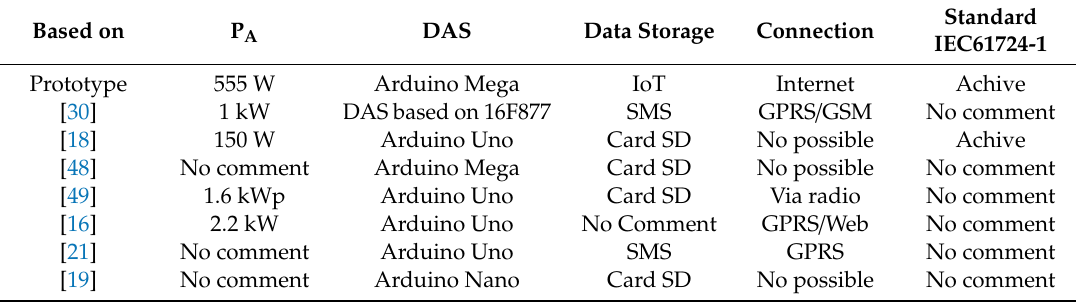
Table 3. Comparison the potential solutions of monitoring system. DAS: data acquisition